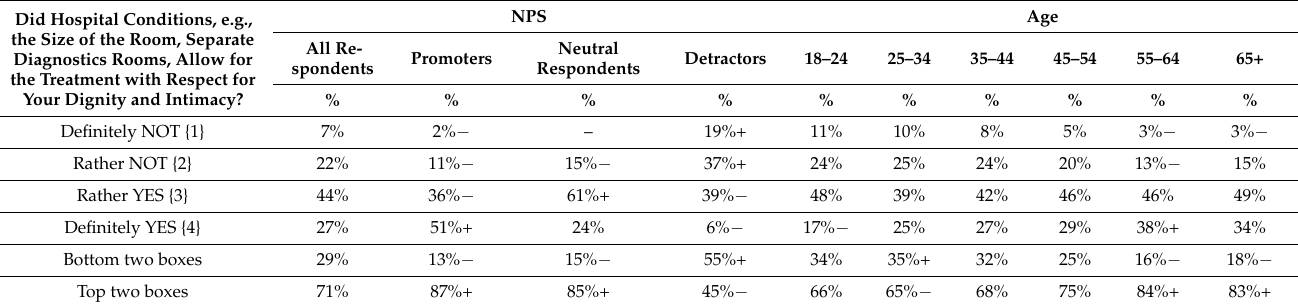
Table 6. Analysis of patients’ opinions on hospital conditions and accessibility of diagnostics and treatment with respect for patient’s dignity and intimacy.